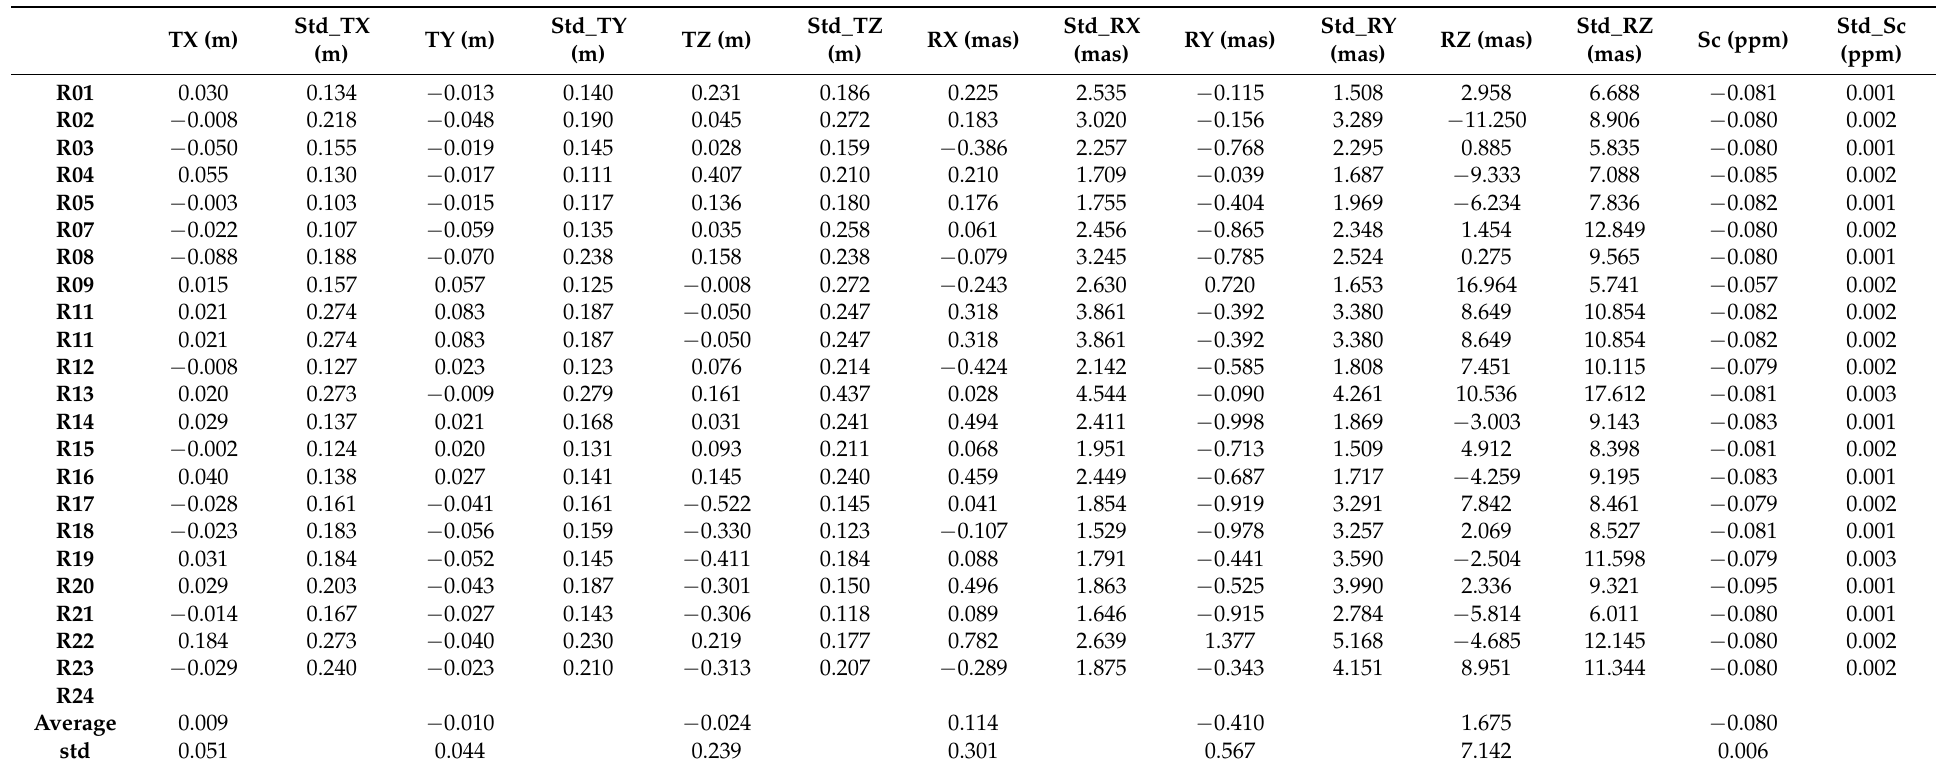
Table A2. Helmert parameters relating the Glonass reference frame to the ITRF2014 reference frame of the precise ephemeris of CNES. Average values for January 2020.